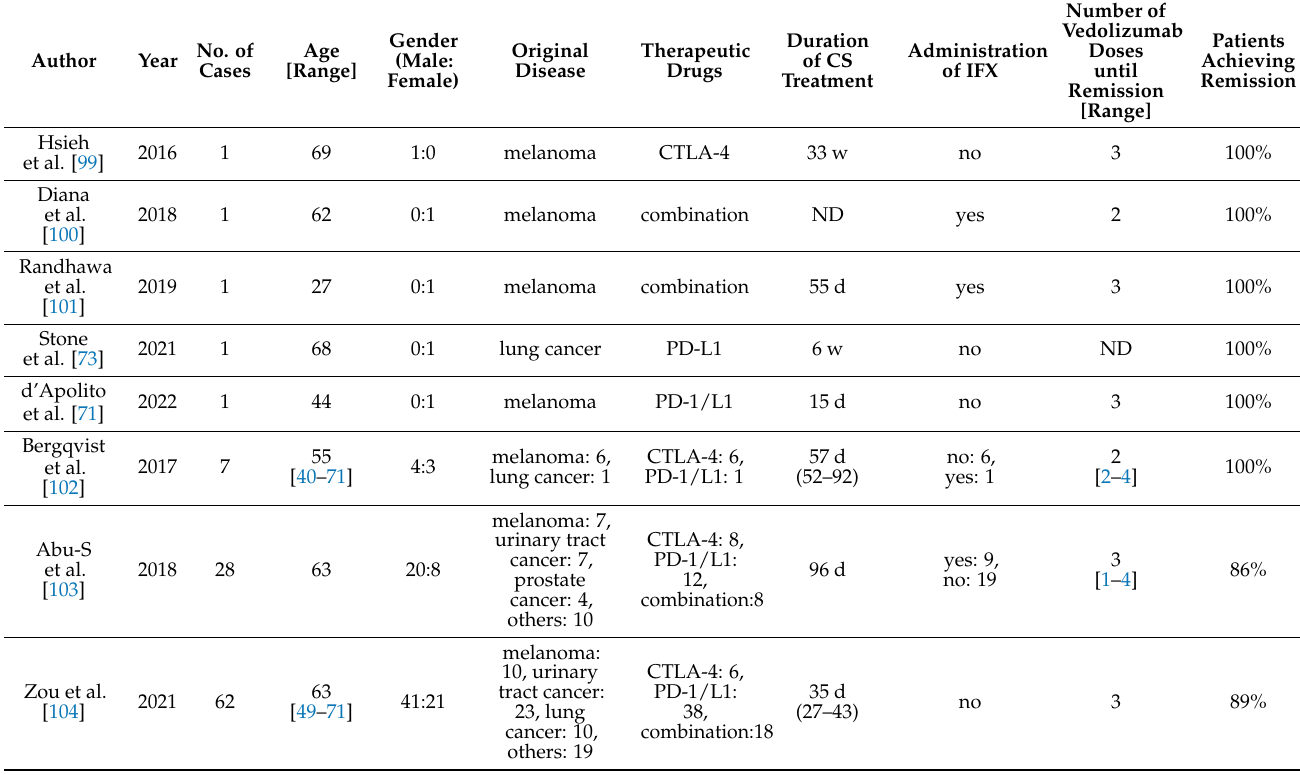
Table 4. Summary of the cases of vedolizumab use for irAE